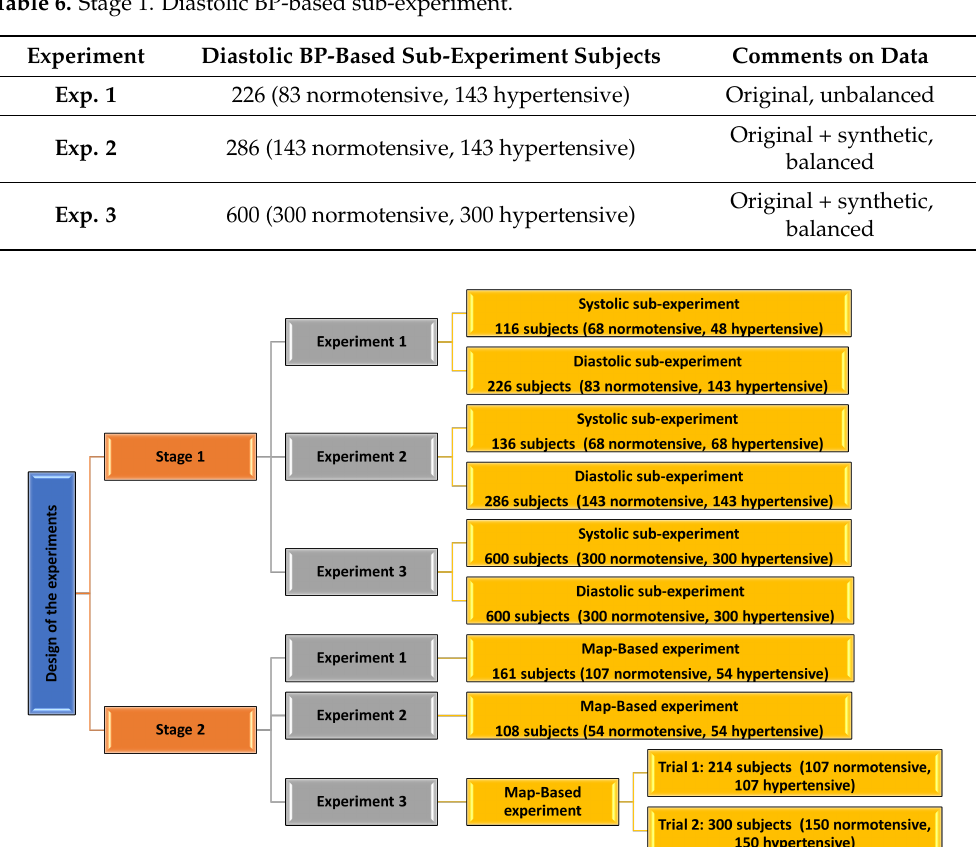
Table 6. Stage 1. Diastolic BP-based sub-experiment.